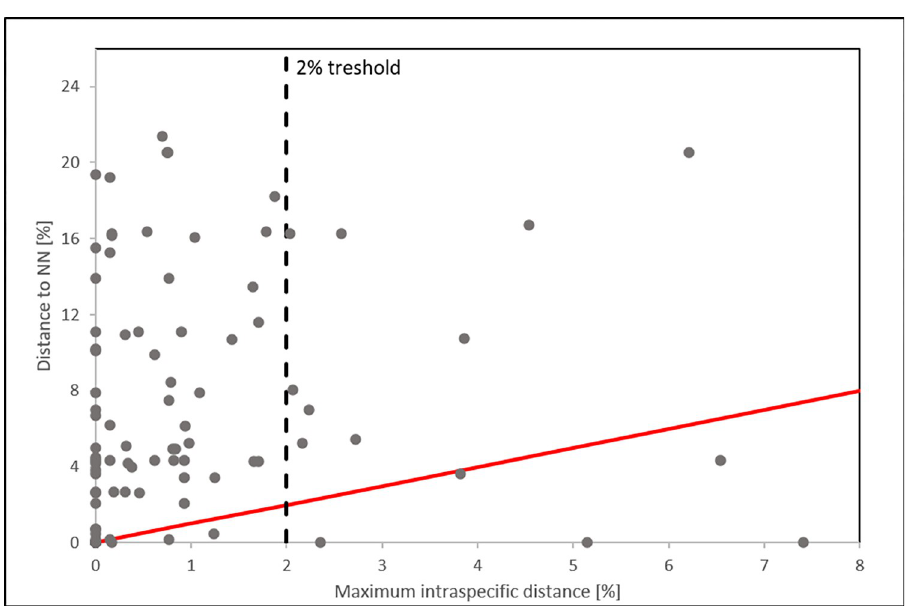
Fig 3. Visualization of the ‘Barcode gap’. Barcode gap plot of the distance to the nearest neighbor (NN) vs. the maximum intraspecific distance of Austrian fish species. Dots above the red line suggest the presence of a barcoding gap. Outliers were detected in Abramis brama , Barbus barbus , Blicca bjoerkna , Carassius auratus , Carassius gibelio , Eudontomyzon marie , Leuciscus idus , Leuciscus leuciscus and Phoxinus spp.